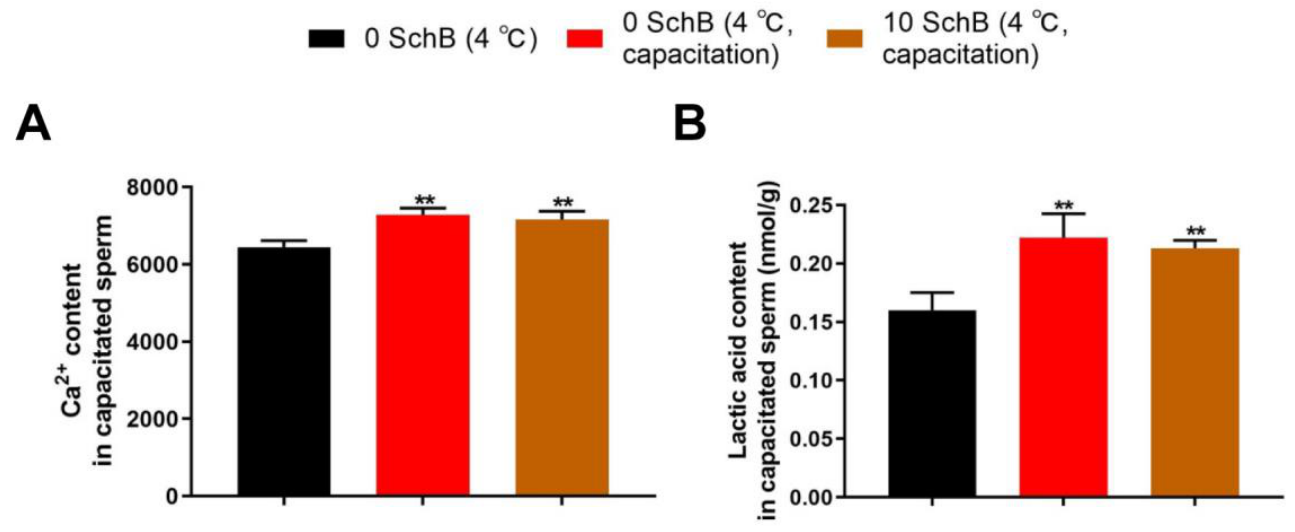
Figure 9. Effects of Sch B on Ca 2+ ( A ) and lactic acid ( B ) content in capacitated boar sperm: Data are expressed as mean ± SD ( n = 12). ** p < 0.01 vs. 0 Sch B.